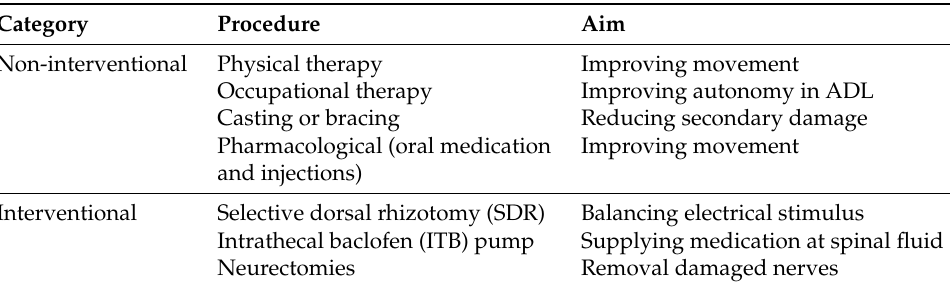
Table 2. Overview of treatments for